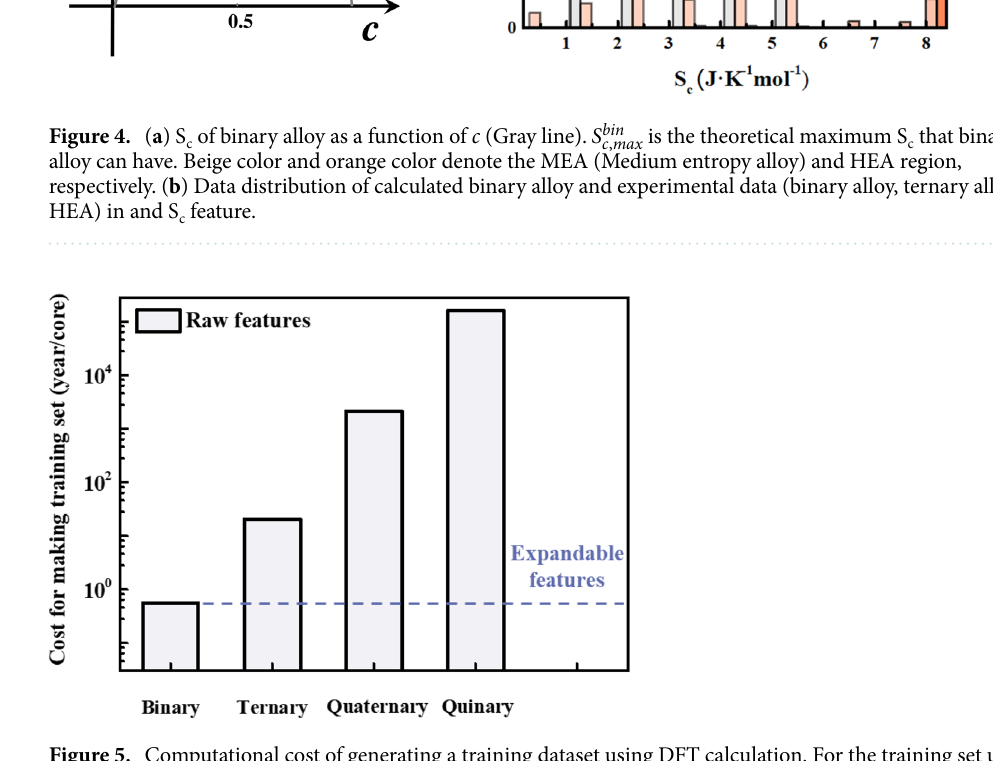
Figure 5. Computational cost of generating a training dataset using DFT calculation. For the training set using raw features, we suppose that 80% of the training set is required from the original dataset. However, using expandable features, the cost for generating the training set of the binary alloy is only required because the training algorithm using expandable features can be directly applicable to the multi-element